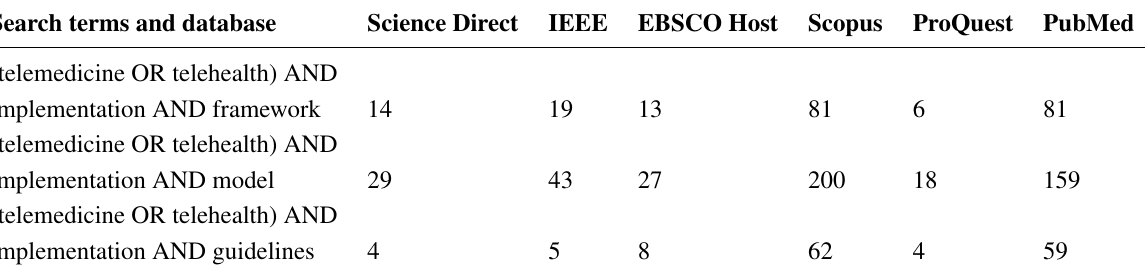
Table 1. Search terms and